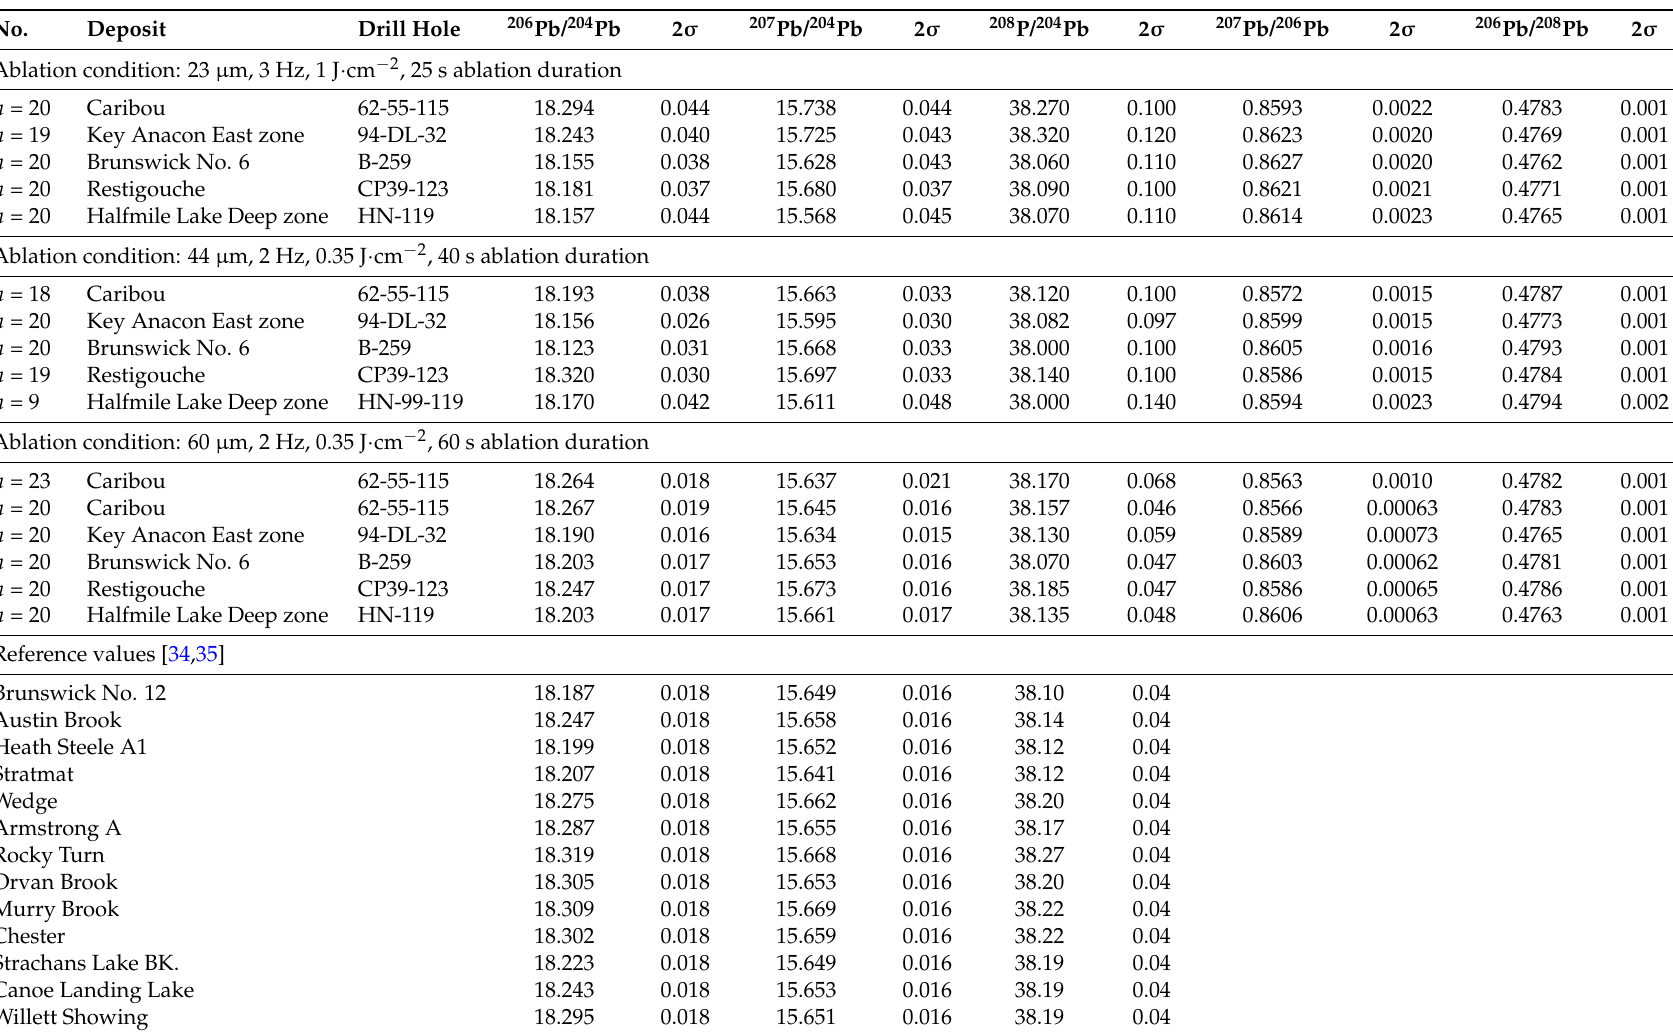
Table 1. LAICP-MS Pb isotope ratios (all data) for galena from representative massive sulphide deposits of the